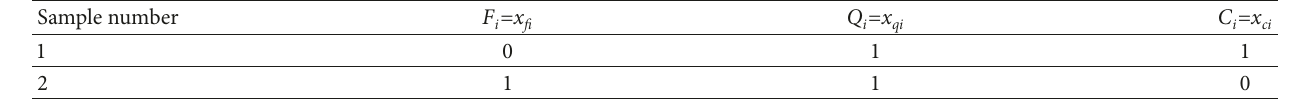
Figure 3: BN structure diagram. Table 2: Sample configuration